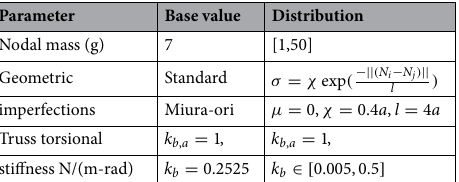
Table 3. Variables for reservoir size and material properties parametric study.